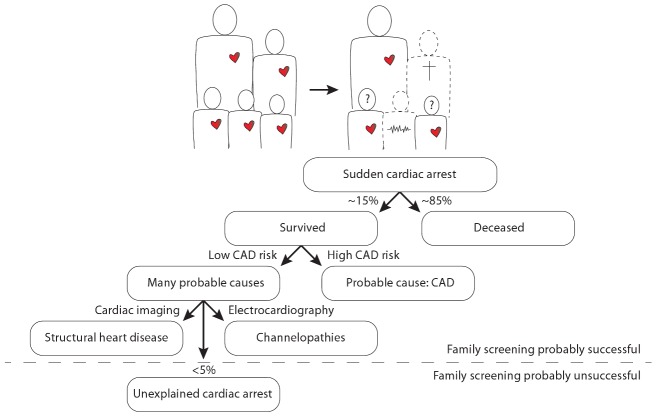
Illustration of the position of unexplained cardiac arrest among sudden cardiac arrest, focused on the occurrence of familial sudden cardiac arrest.The question marks denote the uncertainty in the remaining siblings as to whether they too have an increased risk for sudden cardiac arrest and whether it is possible that they transmit this risk to their own offspring. CAD denotes coronary artery disease.